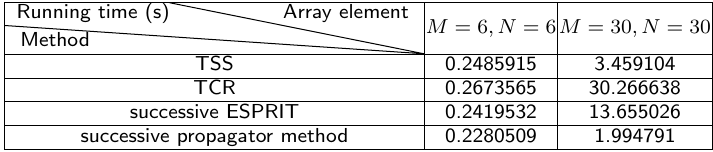
Table 1 Running time comparison MethodRunning time